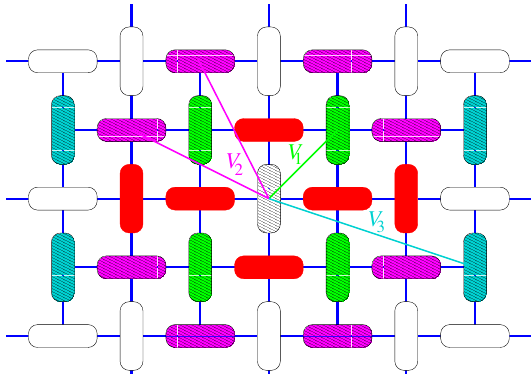
Figure 4: A schematic representation of effective pair interactions between triplons. Red rounded rectangles around the central dimer in the triplet state (dashed rounded rectangle) show the hard-core condition, the colored rectangles indicate the interac- tion between the central triplon and its further